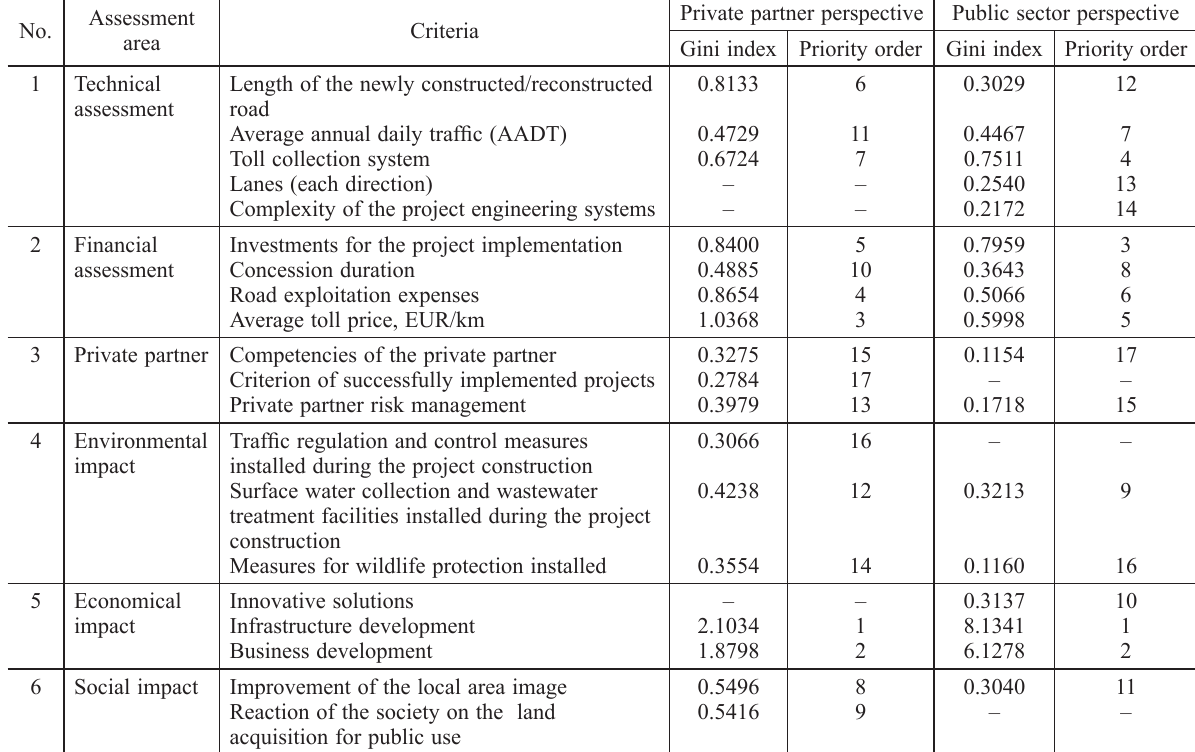
Table 5. The priority order of the most significant criteria